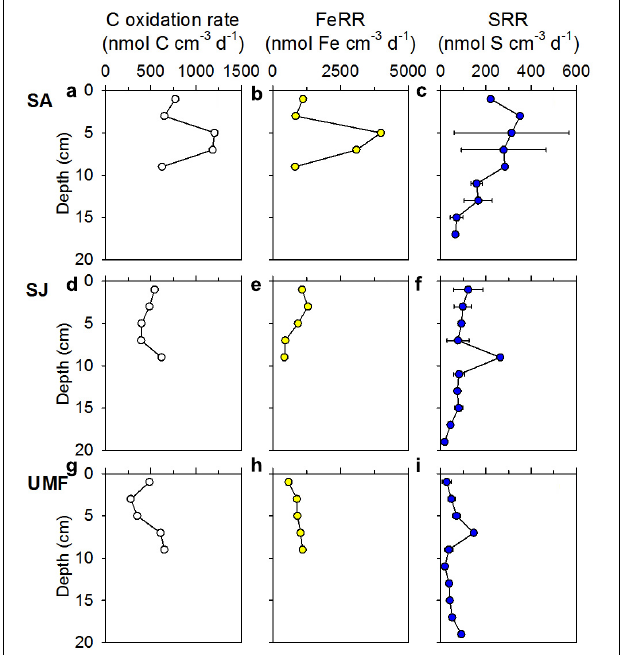
FIGURE 5 | Vertical profiles of anaerobic C org oxidation rates (a,d,g) , iron reduction rates (FeRR) (b,e,h) , and sulfate reduction rates (SRR) (c,f,i) in the sediments vegetated by Spartina anglica (SA) and Suaeda japonica (SJ) and unvegetated mud flats (UMF). Error bars in SRR indicate the mean ± 1 SD from triplicate